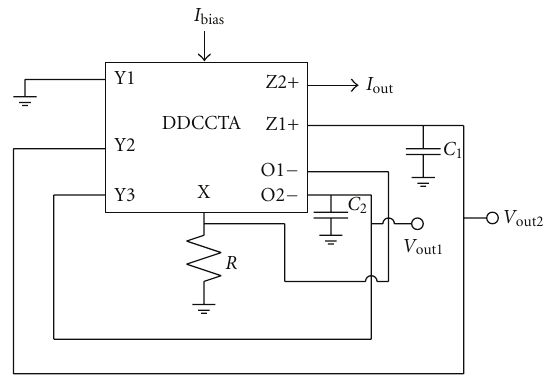
Figure 10: Proposed